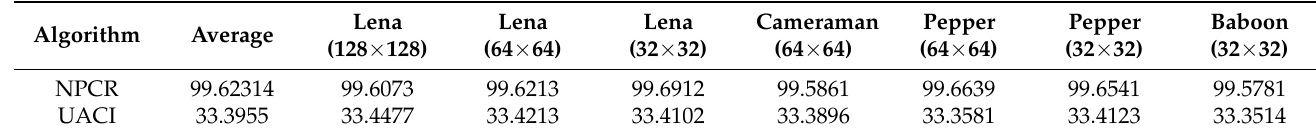
Table 2. NPCR and UACI values of Cipher text images.